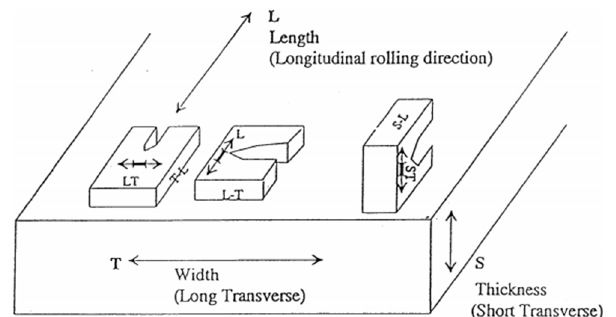
Figure 3. Specimen orientations used for fracture toughness test.